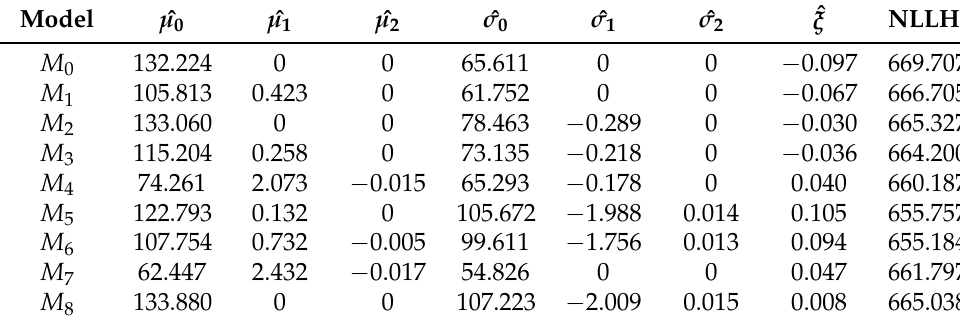
Table 11. Non-stationary GEVD models for Limpopo for the period